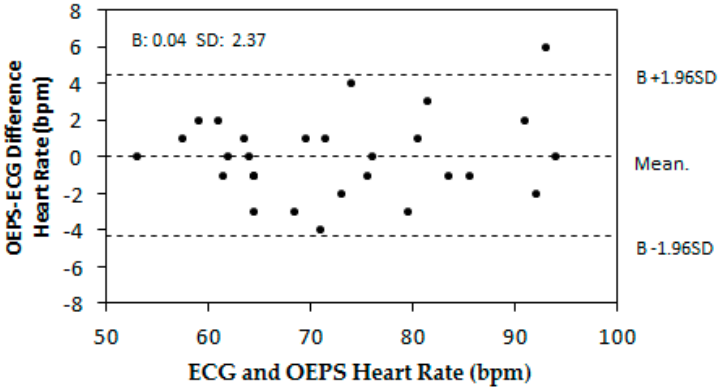
Figure 8. Differences in heart rate (HR) outputs recorded at resting using Bland–Altman plot. The acceptable range: B ± 1.96SD.